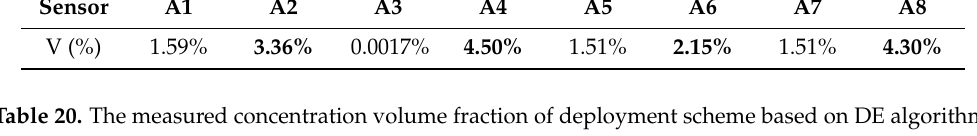
Table 19. The measured concentration volume fraction of deployment scheme based on PSO algorithm.